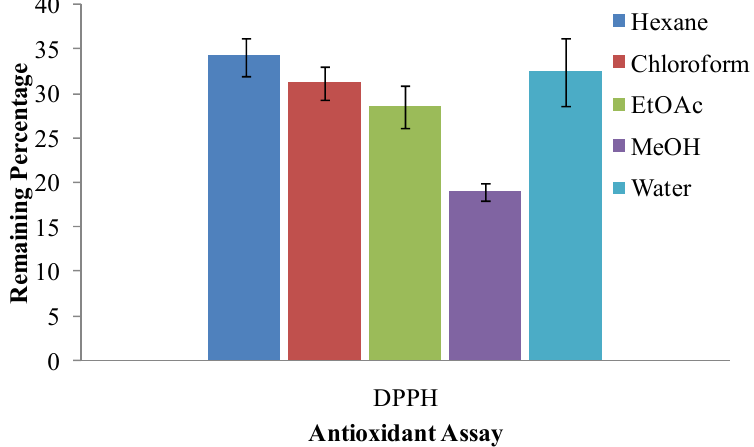
Figure 3. DPPH radical scavenging potential of various solvent extracts of Artimisia annua leaves.